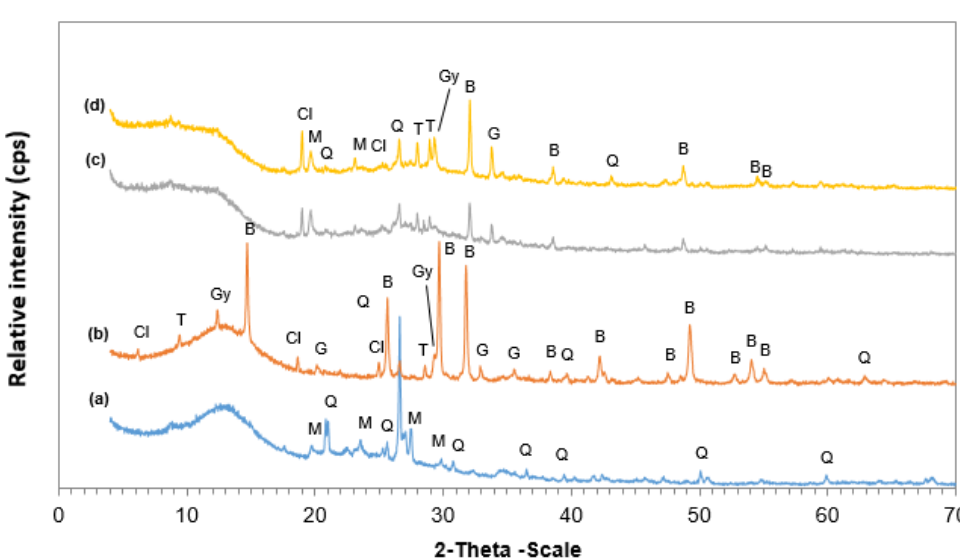
Figure 3. XRD patterns of (a) metakaolin (MK), (b) leaching residues PLR, (c) PLR50MK50, and (d) PLR70MK30 AAMs. Phases identified are: bassanite (B), calcite (C), clinochlore (Cl), goethite (G), gypsum (Gy), muscovite (M), quartz (Q), talc (T). The AAMs produced at 40 °C with the use of 10 M NaOH.